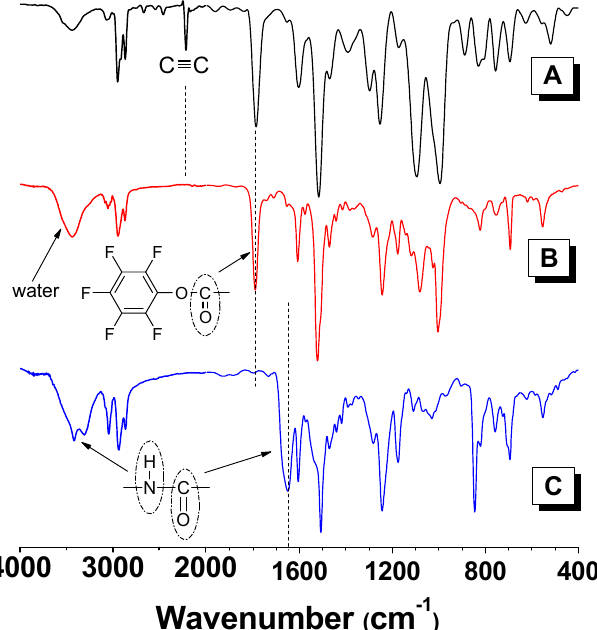
Figure 2. FTIR spectra of ( A ) monomer 1 , ( B ) precursor P 0 bearing activated ester groups, and ( C ) pyrene-functionalized poly(diphenylacetylene) derivative P 1 pyrene-functionalized poly(diphenylacetylene) derivative P 1 .